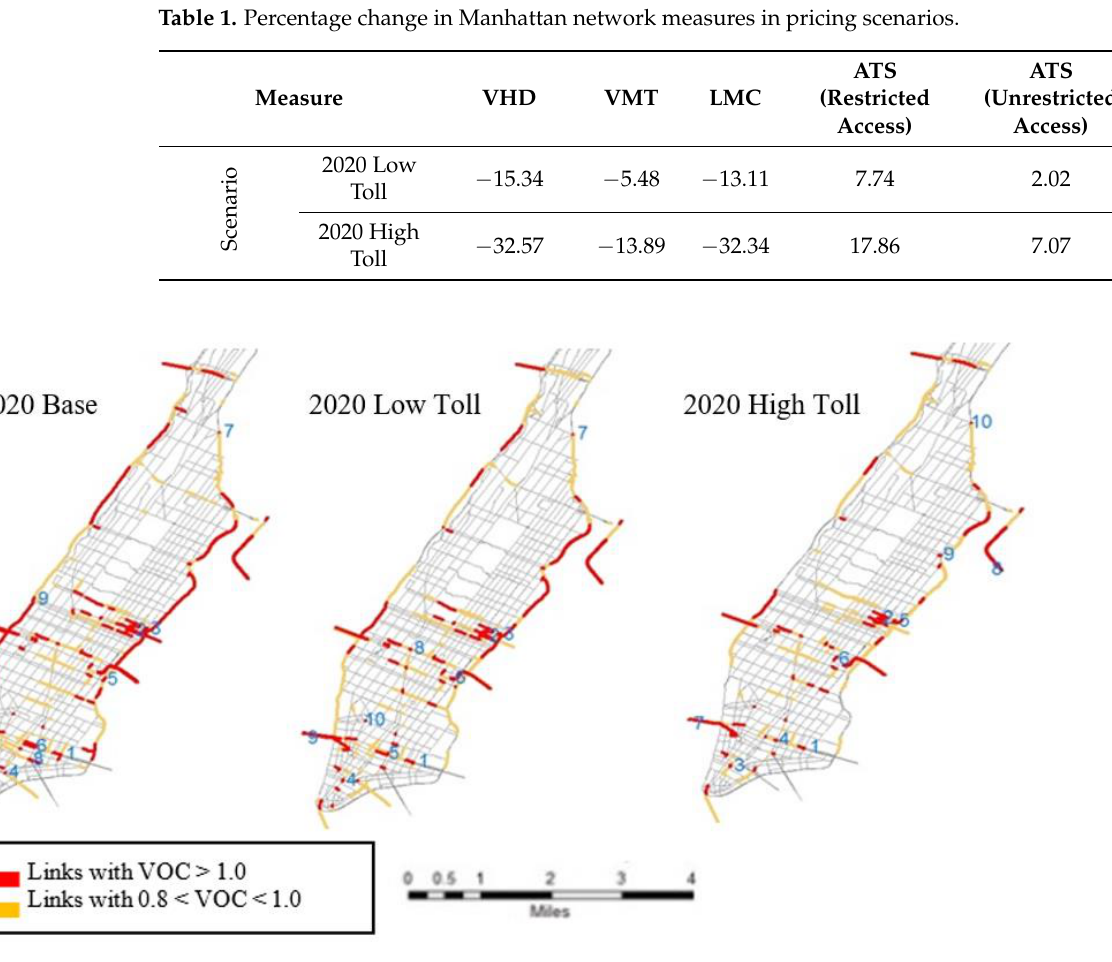
Figure 9. Pricing scenario impact on Manhattan traffic conditions in the morning peak period (AM) [91].